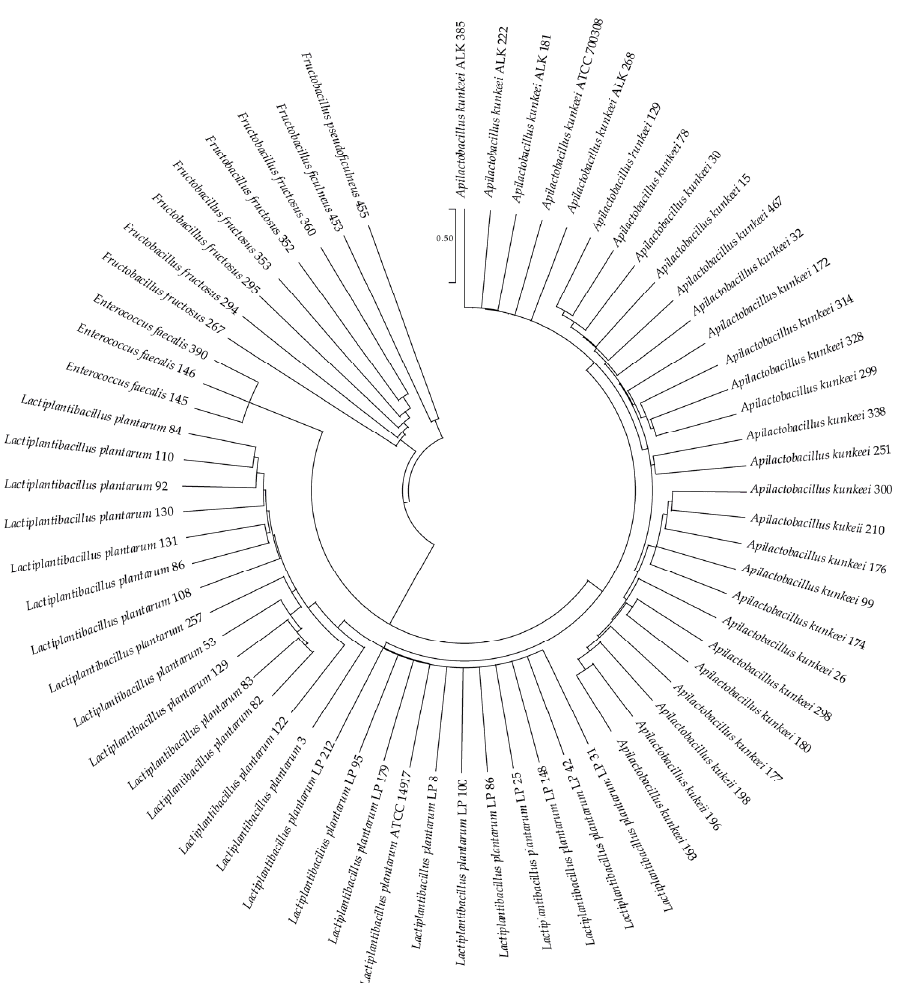
Figure 1. Phylogenetic analysis of the 16S rRNA gene sequences of the sixty-five LAB isolates. The type strains Lactiplantibacillus plantarum ATCC 14917 and Apilactobacillus kunkeei ATCC 700308 have been used as references. The analysis was conducted with the MEGA X [85] program using the maximum likelihood method and the Kimura 2-parameter model [89]. The scale bar represents a 0.5% nucleotide sequence difference.